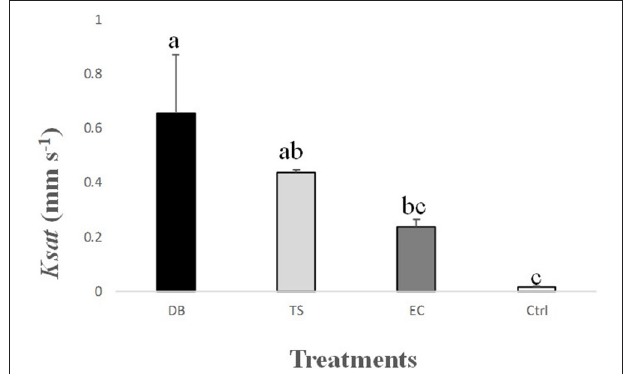
FIGURE 5 | Influence of the treatments on Ksat (mm s − 1 ). Treatments are “DB” for dung beetles, “TS” for termite sheetings, “EC” for earthworm casts, and “Ctrl” for control. Error bars represent the standard error of the mean. Histograms with the same letters are not significantly different at P = 0.05, n =